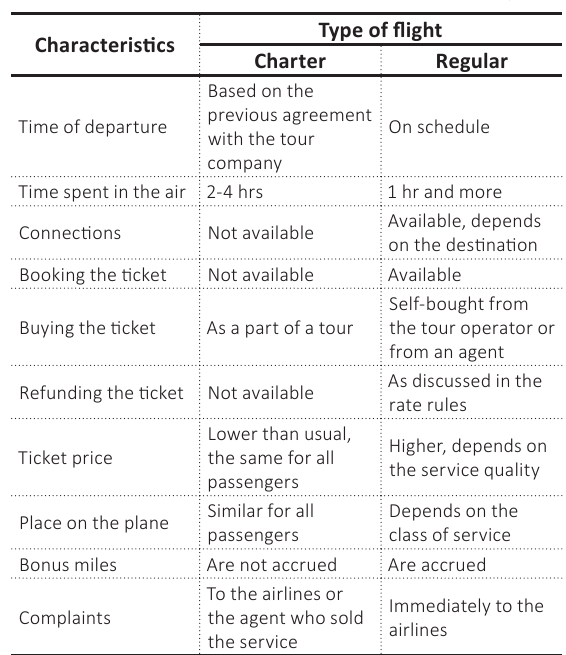
Table 1. The main differences between charter flights and regular